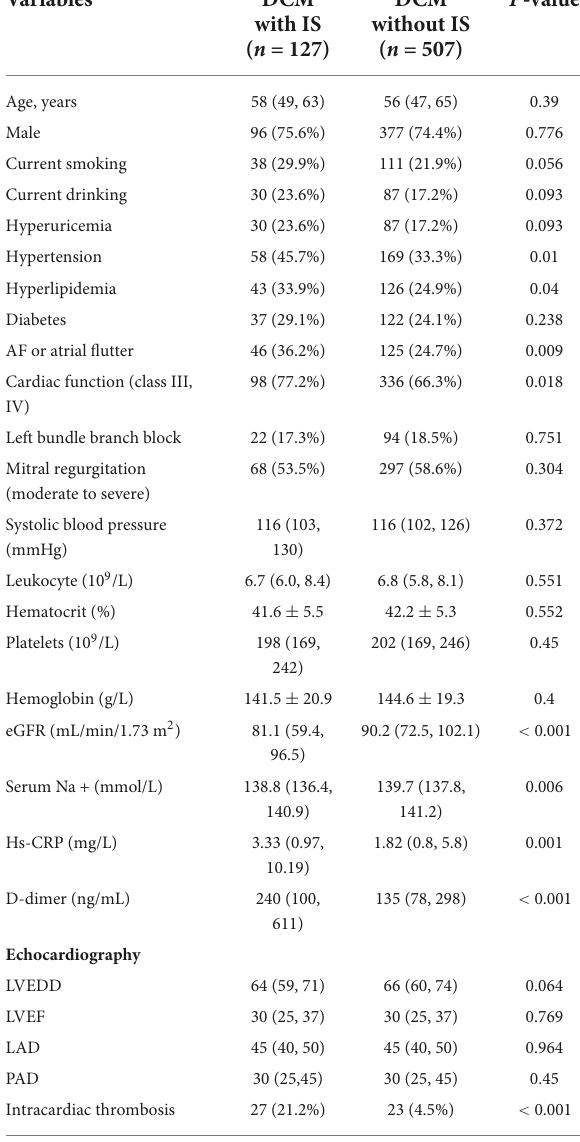
TABLE 1 Baseline data of patients with dilated cardiomyopathy (DCM).